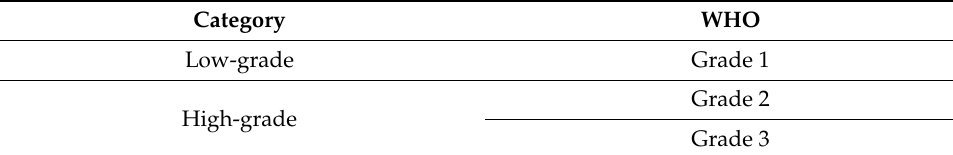
Table 2. Histopathological grading systems for bone tumors